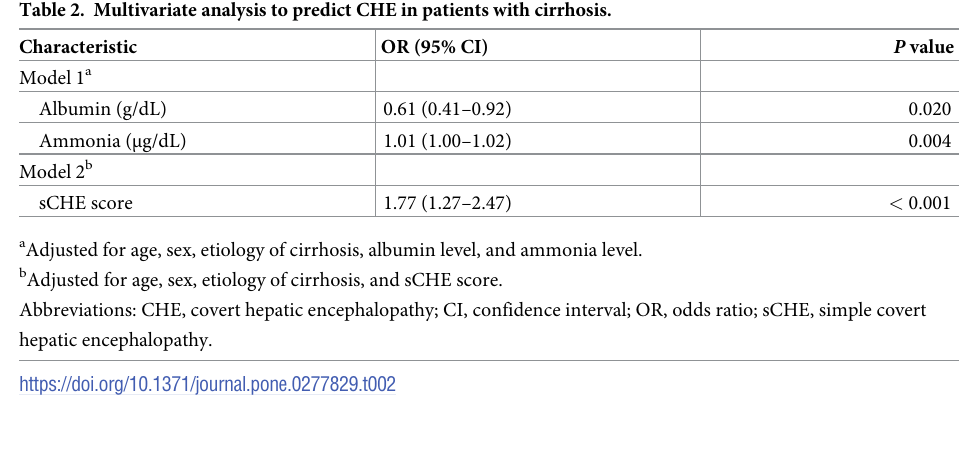
Table 2. Multivariate analysis to predict CHE in patients with cirrhosis.